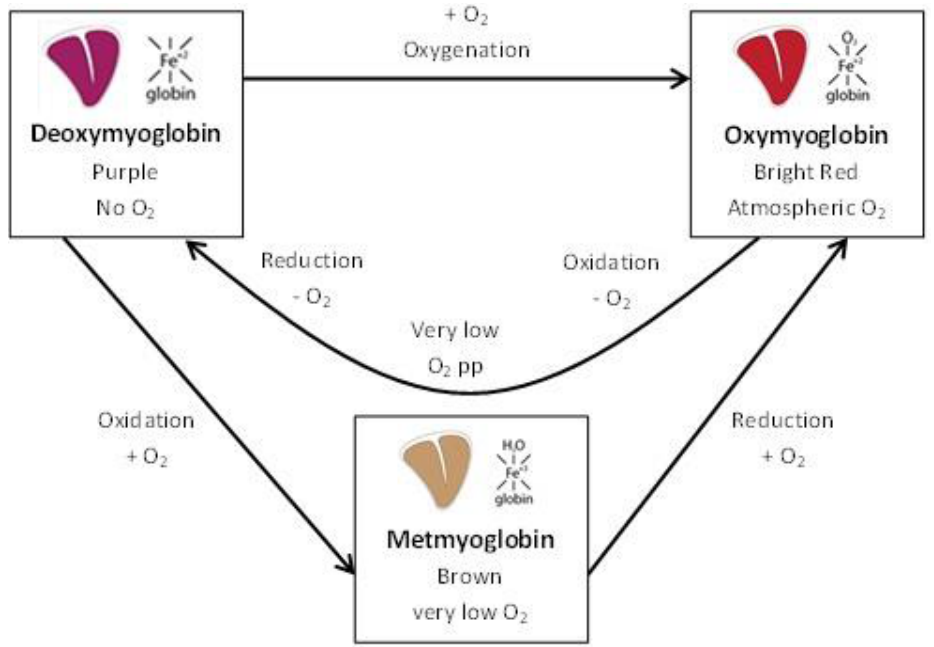
Figure 2. Visible myoglobin redox interconversions on the surface of meat. Inspired by